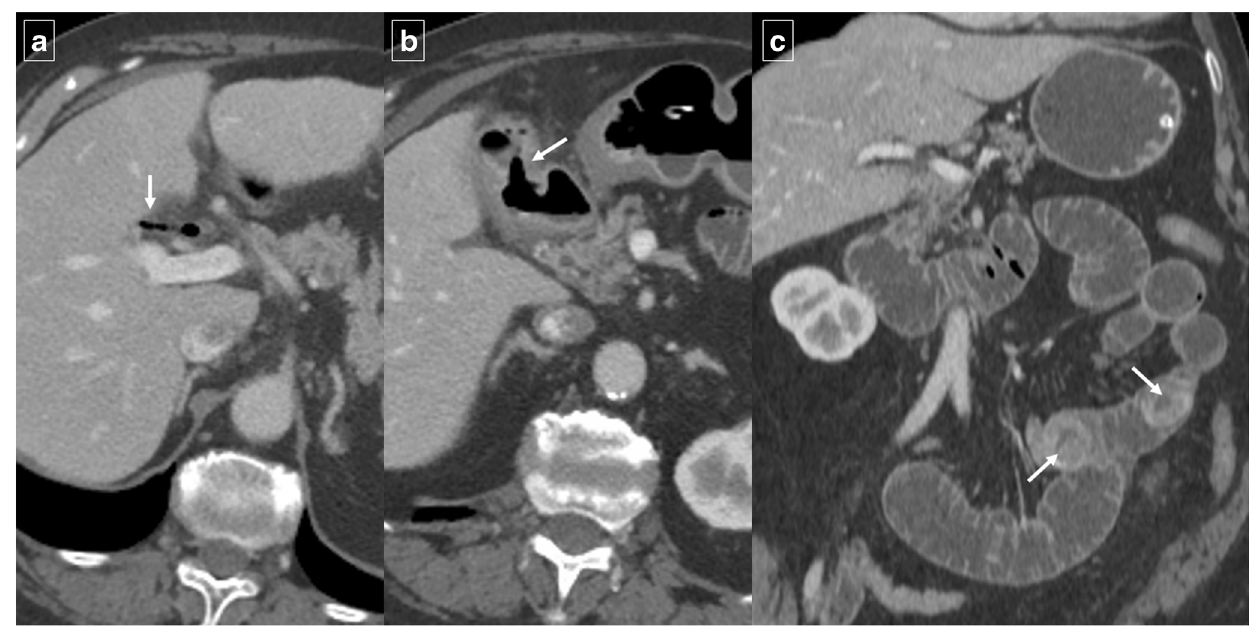
Fig. 20 Right upper quadrant pain and gallstone ileus in a 39-year-old woman. Axial contrast-enhanced CT ( a and b ) shows air in the bile duct (arrow in a ), a thick-walled gallbladder, and a fistula to the duodenum